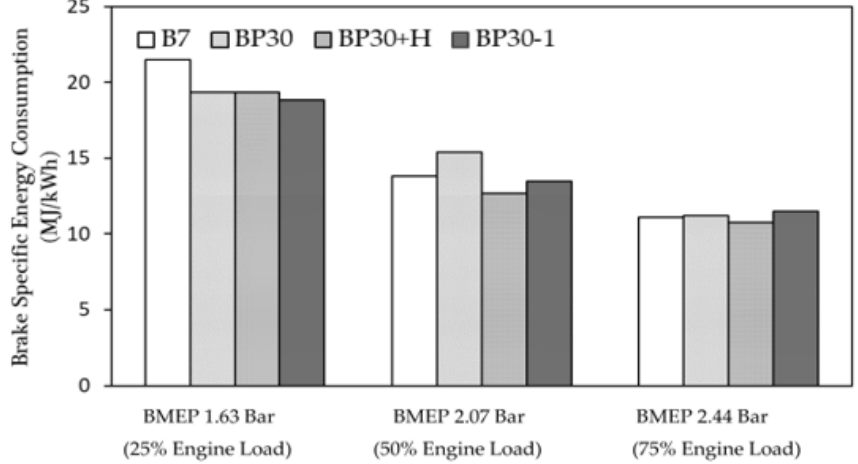
Figure 11. Effects of fuel enhancement on brake specific energy consumption.